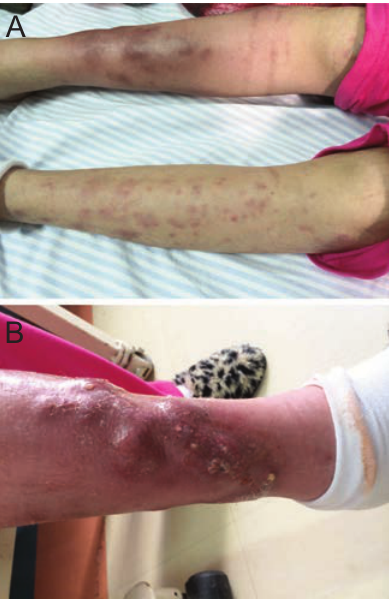
Figure 2. A) Right lower extremity lesions, which were blistered, painful upon palpa- tion, and showed signs of inflammation. B) Purulent secretion draining from the lesions.